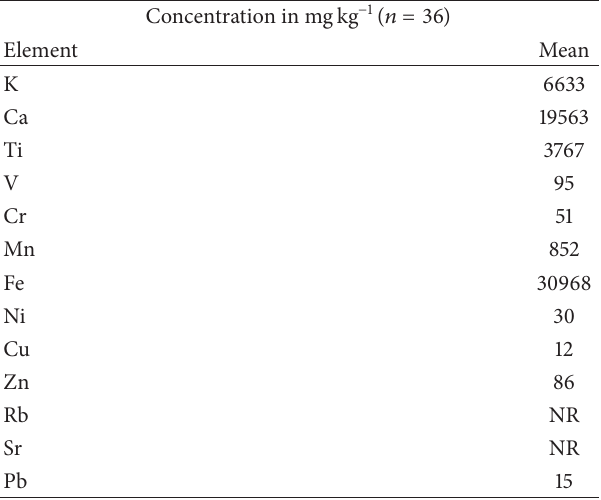
Table 5: Mean concentration in reference soils at the Metropolitan Zone of the Toluca